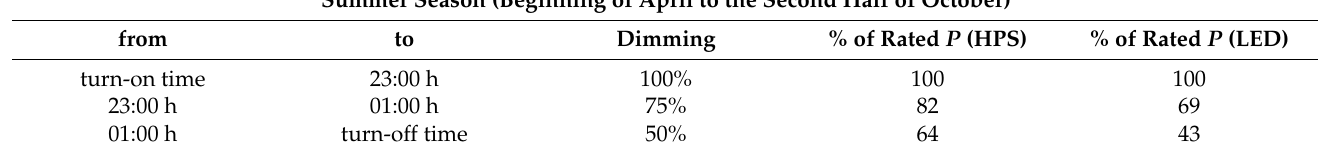
Table 6. The principle of dimming control.